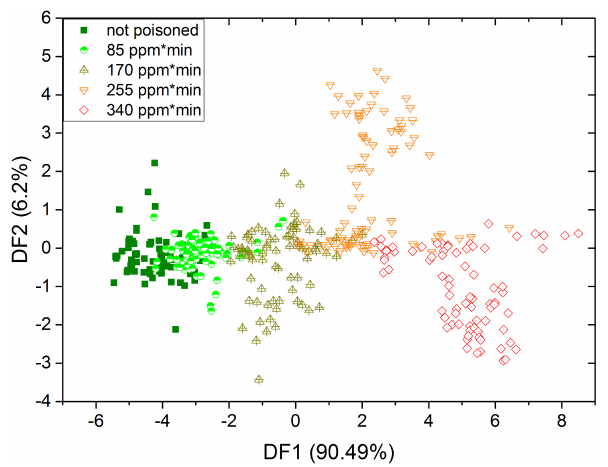
Figure 2. LDA plot showing the discrimination of different poi- soning states using data from gas exposures to carbon monoxide (1/5ppm), ethanol (1/5ppm) and pure air, each at 40 and 60%RH. The 24 features used for this LDA are based on non-normalized conductance values.